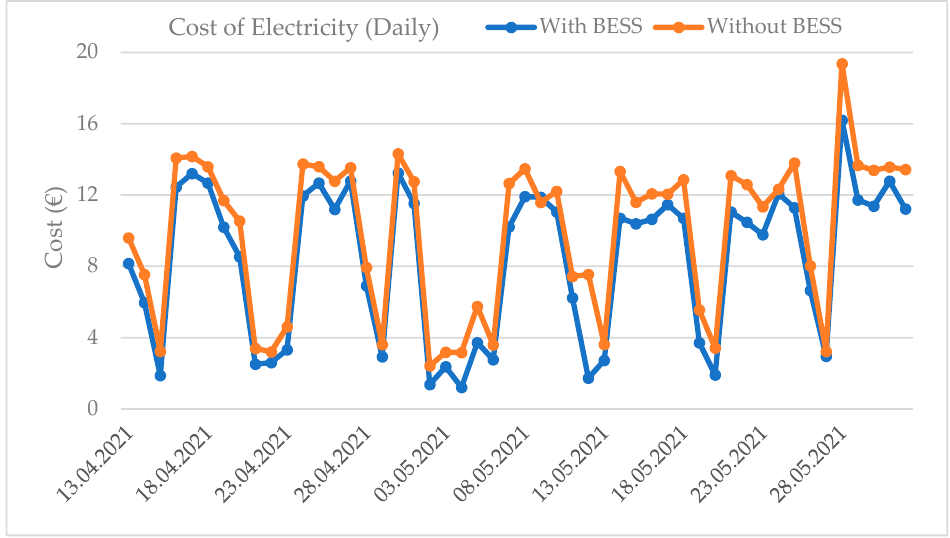
Figure 11. The daily cost of imported electricity before and after the use of BESS . The consumption is measured every 15 min, every single point in the figure represents the total consumption of one day (sum of 96 measurements).